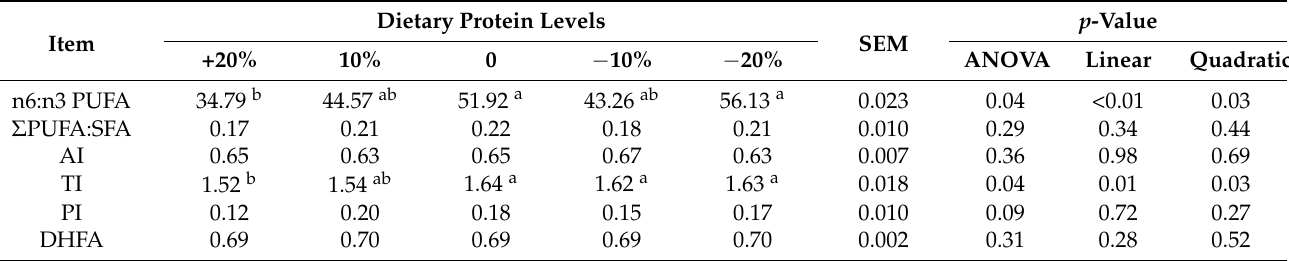
Table 7. Effects of long-term protein restriction on health lipid indices in longissimus thoracis muscle of Shaziling